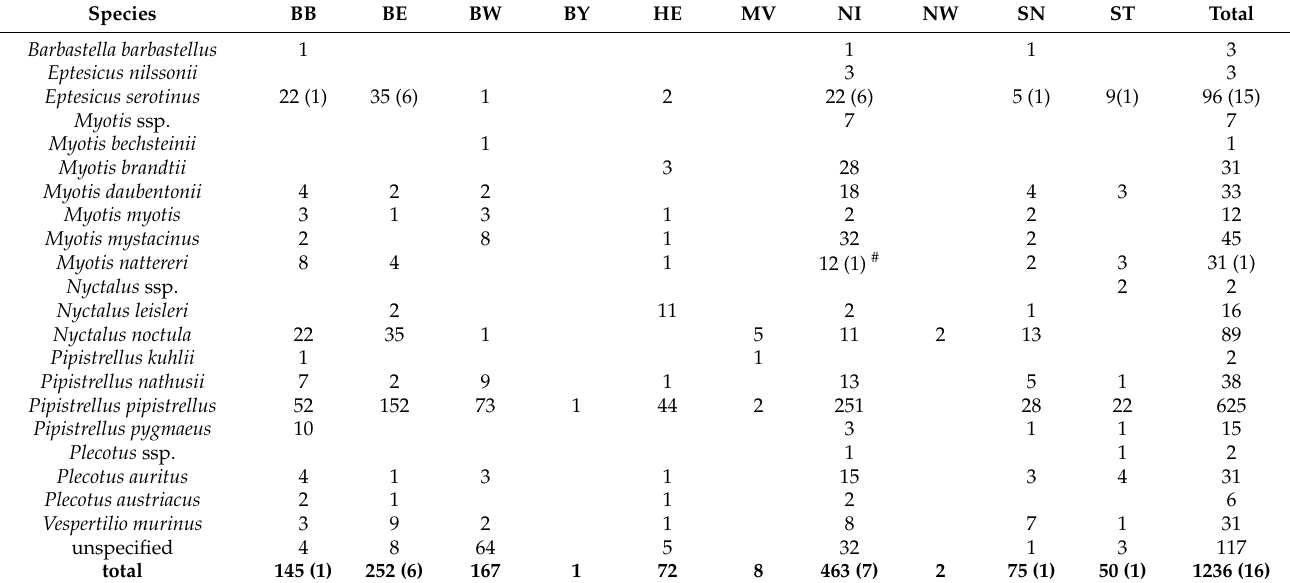
Table 1. Details of passive bat rabies surveillance. Numbers of animals investigated per species and federal state. Lyssavirus- positive cases are indicated (in brackets). All viruses were characterized as EBLV-1, except for one case in the Natterer’s bat. Abbreviations for German federal states: Baden-Wuerttemberg (BW), Bavaria (BY), Berlin (BE), Brandenburg (BB), Hesse (HE), Lower Saxony (NI), Mecklenburg-Western Pomerania (MV), Northrhine-Westphalia (NW), Saxony-Anhalt (ST), Saxony (SN).